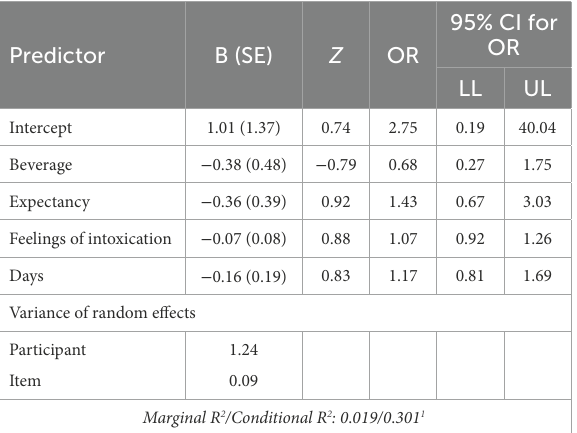
TABLE 2 Multi-level logistic regression analyses predicting memory accuracy for consensual sexual activity.